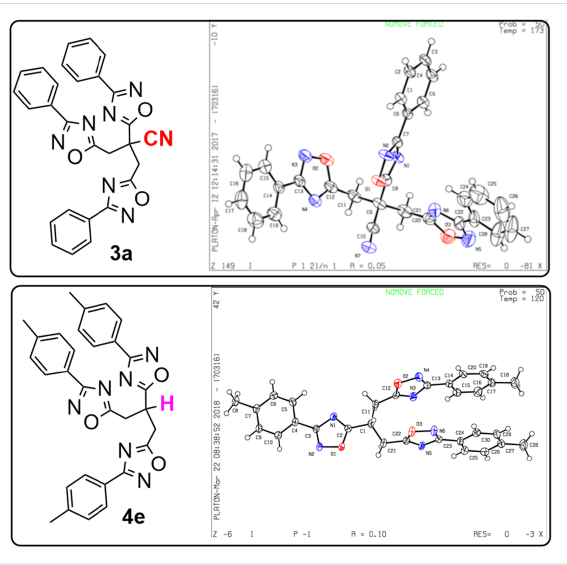
Figure 4: X-ray ORTEP plots of 3a and 4e